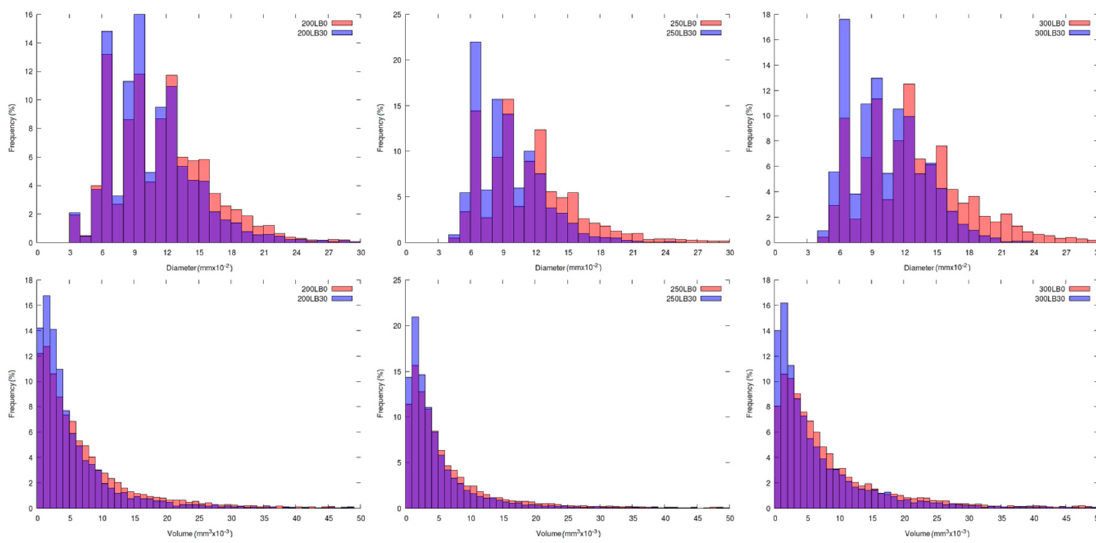
Figure 3. Histograms showing the distribution of the pore size (upper line) and pore volume (lower line) of PUR-PIR foams for different isocyanate indexes.